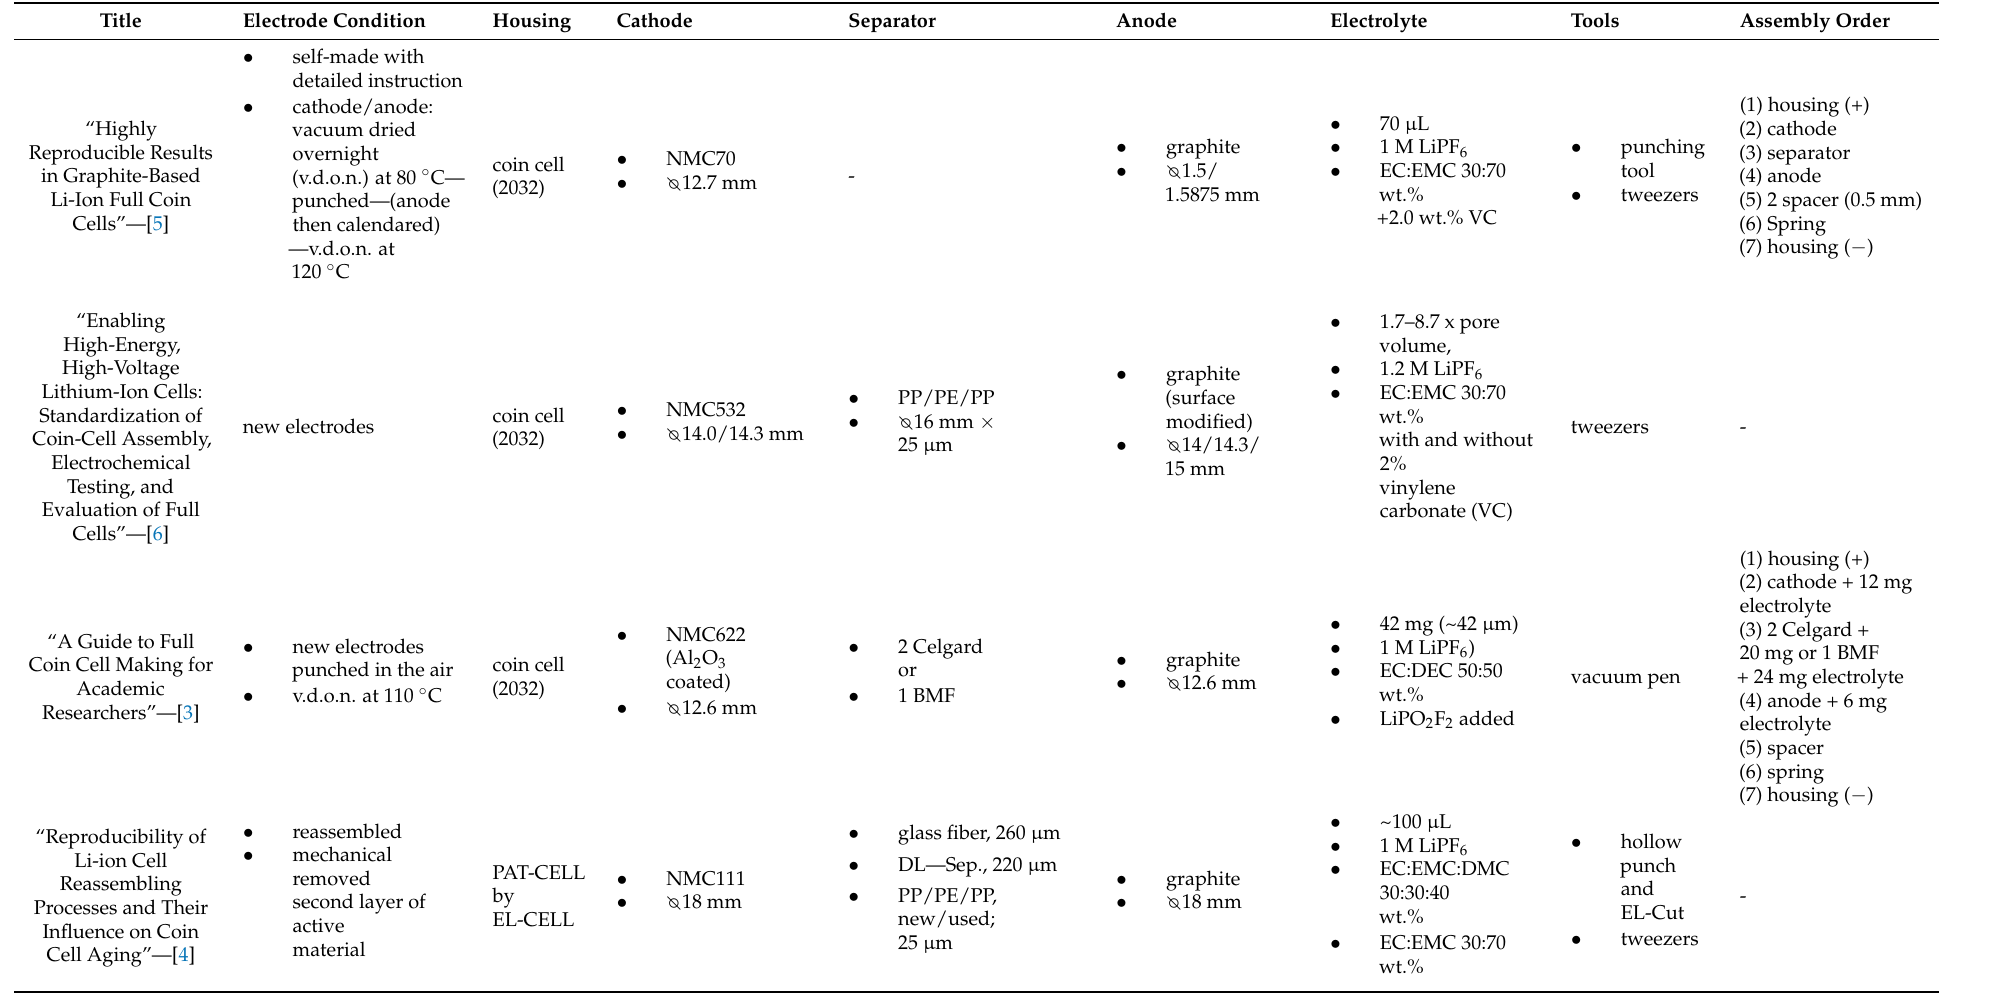
Table 1. Reproducible production of coin cells in the literature